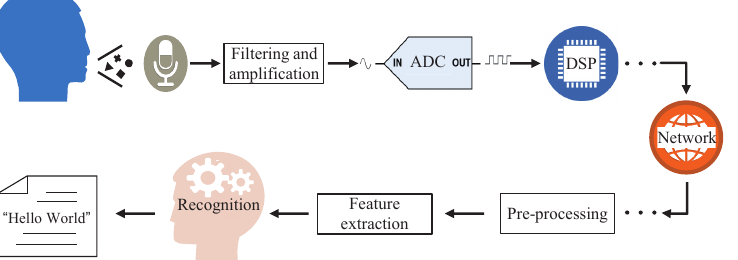
Figure 1. General audio signal flow of the ASR deployed in the human–computer interaction system.